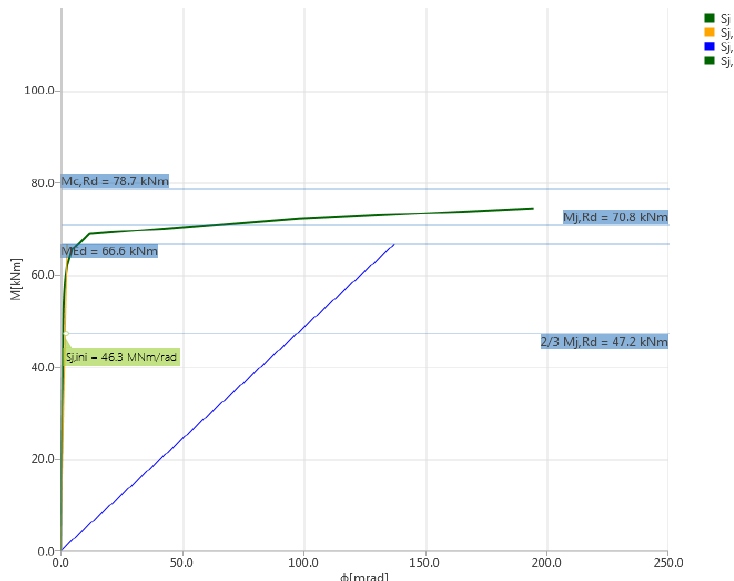
Fig. 8. Stiffness diagram of the adopted RBA flange cut